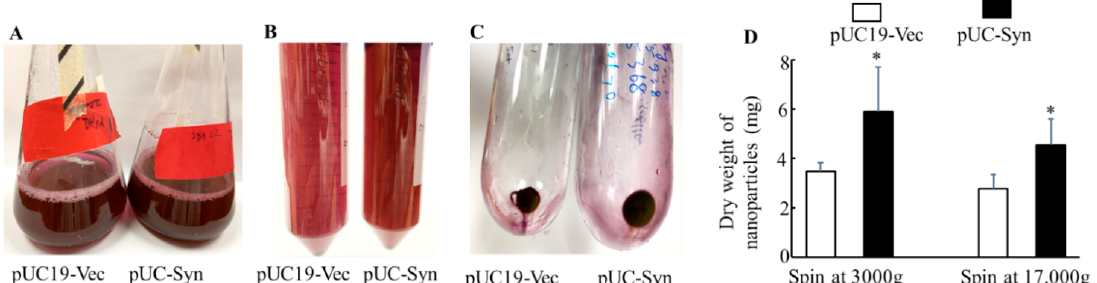
Figure 2. Synthesis and yield of gold nanoparticles by soluble intracellular extracts from bacteria. ( A ). Soluble intracellular reaction mix after 7 days of incubation with 2 mM HAuCl 4 . ( B ). Superna- tant collected after centrifugation of the reaction mix in A at 3000 g for 5 min. ( C ). Nanoparticle pellets obtained after further centrifuging the supernatant in ( B ) at 17,000× g . ( D ). Dry weight of nanoparticle pellets collected from 100 mL cell-free reaction mix after centrifugation at 3000 g and 17,000 g, respectively. n = 4. *: p < 0.05.